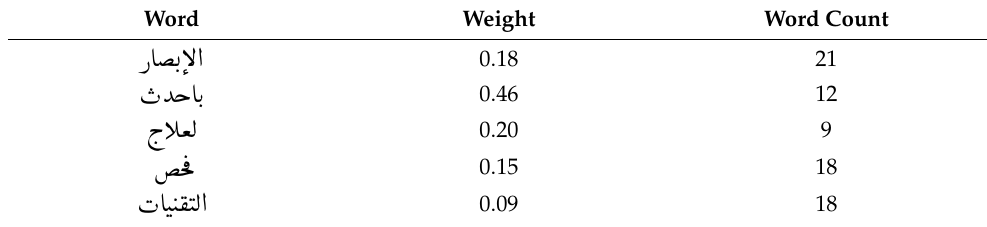
Figure 5. LIME results for LASIK surgery neutral sentiment. Table 3. Word counts and LIME-based weights of words.